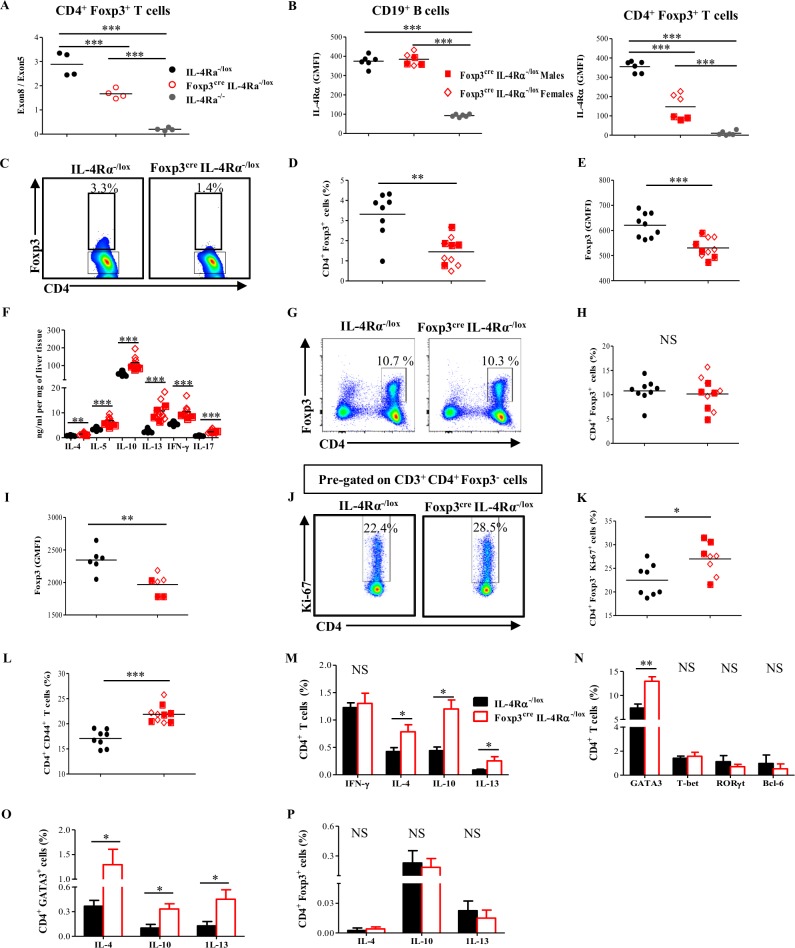
IL-4Rα-mediated signaling on Foxp3+ Treg cell is required for the accumulation of Treg cells and the control of effector T-cells.IL-4Rα−/lox, Foxp3cre IL-4Rα−/lox, and IL-4Rα−/− mice were infected with Sm cercariae and euthanized 8 wk post infection. (A) Efficiency of il4ra deletion by qPCR. CD4+ Foxp3+ T cells were sorted 8 wk post infection from pooled spleen and MLN cells, genomic DNA was extracted, and the ratio of exon8:exon5 was calculated. (B) Flow cytometry analysis of IL-4Rα expression by CD19+ B cell and CD4+ Foxp3+ T cell in pooled spleen and MLN cells 8 wk post infection. (C) Representative flow cytometry of CD4+ Foxp3+ T cells from the liver of mice infected with Sm for 8 wk. (D) Frequency of CD4+ Foxp3+ T cells (left) and (E) Foxp3 GMFI in CD4+ Foxp3+ T cells from (C). (F) Liver cytokine production 8 wk post infection. Livers from infected mice were homogenized, and the levels of the indicated cytokines were detected by ELISA and normalized to mg of liver tissue. (G) Representative flow cytometry of CD4+ Foxp3+ T cells from the MLN of mice infected with Sm for 8 wk. (H) Frequency of CD4+ Foxp3+ T cells (left) and (I) Foxp3 GMFI in CD4+ Foxp3+ T cells from (G). (J) Representative flow cytometry of CD4+ Ki-67+ cells within CD4+ Foxp3− T-cell population in MLN 8 wk post infection. (K) Frequency of CD4+ Ki-67+ cells from (J). (L) Frequency of CD3+ CD4+ CD44+ effector T cells in MLN 8 wk post infection. (M) Frequency of cytokine-producing CD3+ CD4+ T cells, from MLN, after stimulation with PMA/Ionomycin in the presence of monensin. (N) Frequency of indicated transcription factor–expressing CD4+ T cells in the MLN 8 wk post infection. (O) Frequency of cytokine-producing CD4+ GATA3+ T cells, from MLN, after stimulation with PMA/Ionomycin in the presence of monensin. (P) Frequency of cytokine-producing CD4+ Foxp3+ T cells, from MLN, after stimulation with PMA/Ionomycin in the presence of monensin. Results are representative of two independent experiments with 6–10 mice/group. Data are expressed as mean ± S.E.M. NS, P > 0.05; * P < 0.05, ** P < 0.001, *** P < 0.0001 by two-tailed unpaired Student t test. Underlying data can be found in S1 Data. Bcl-6, B cell lymphoma 6; CD3, cluster of differentiation 3; CD4, cluster of differentiation 4; CD19, cluster of differentiation 19; CD44, cluster of differentiation 44; Foxp3, forkhead box P3; GATA3, GATA binding protein 3; GMFI, geometric mean fluorescence intensity; IFN-γ, interferon gamma; IL-4, interleukin-4; IL-4Rα, interleukin-4 receptor alpha; IL-5, interleukin-5; IL-10, interleukin-10; IL-13, interleukin-13; IL-17, interleukin-17; MLN, mesenteric lymph node; NS, not significant; PMA, phorbol myristate acetate; qPCR, quantitative real-time PCR; RORγt, RAR-related orphan receptor gamma; Sm, S. mansoni; T-bet; T-box transcription factor; Treg, regulatory T.